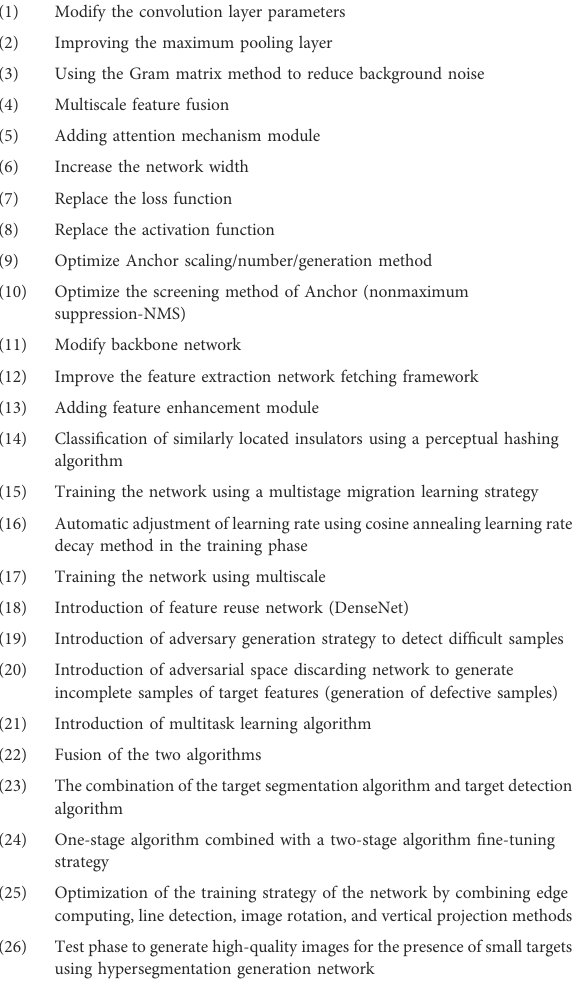
TABLE 2 Algorithm improvement strategies for the comprehensive